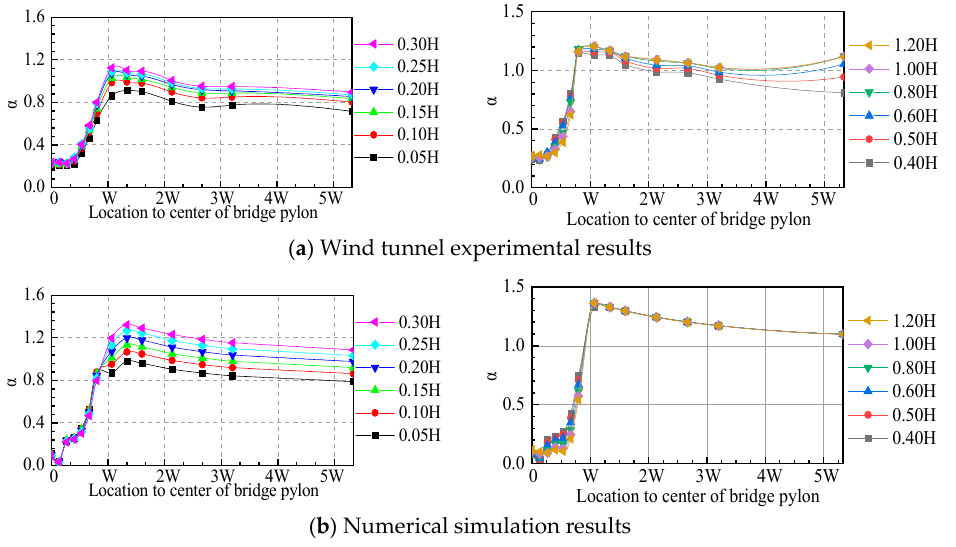
Figure 16. Wind speed coe ffi cient at downstream main lane in C2